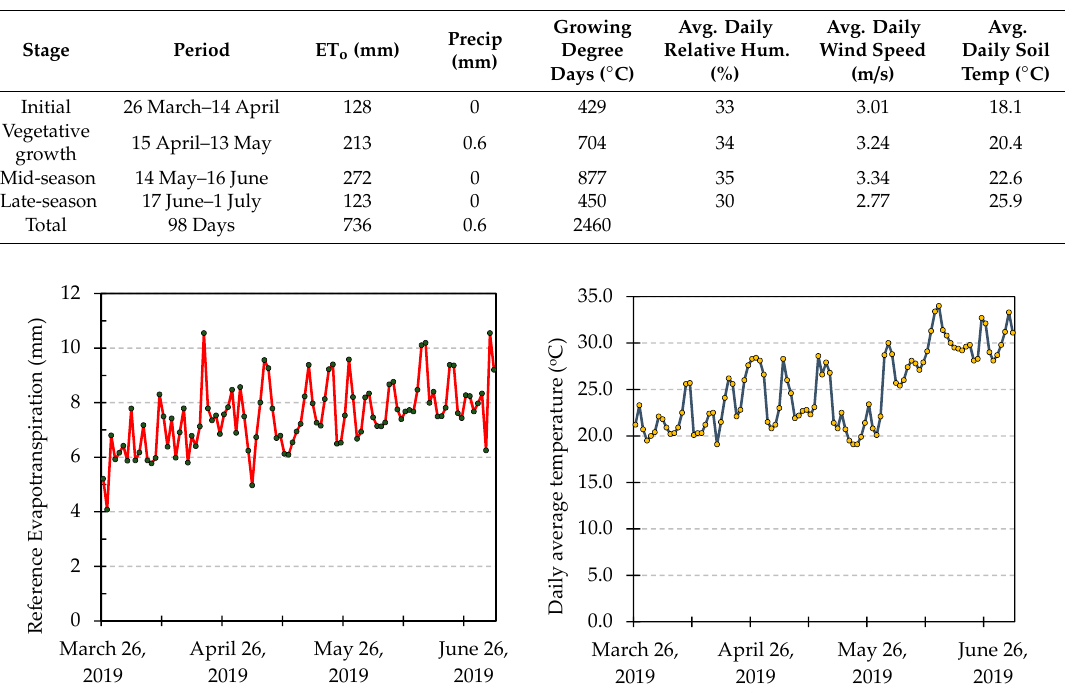
Table 1. Evapotranspiration data through the growing stages [26].